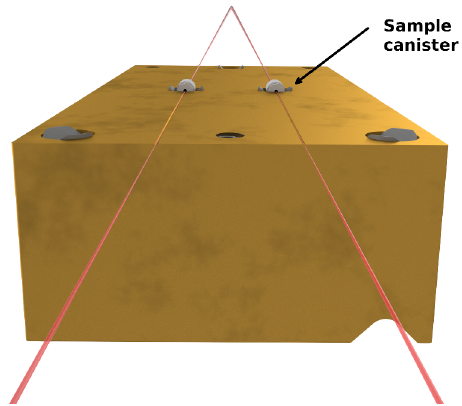
Figure 3. The binocular collimator of DICER allows to perform simultaneous sample in and out measurements, while it also serves as a sample